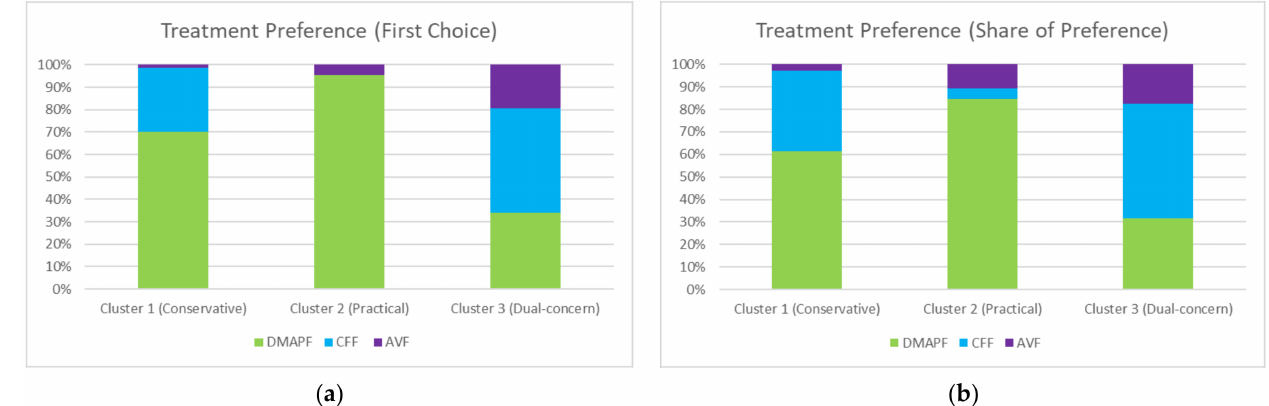
Figure 6. Treatment preferences for the three common flaps: DMAPF (green), dorsal metacarpal artery perforator flap; CFF (blue), cross-finger flap (with groin skin graft); AVF (purple), arterialized venous flap. Most patients in cluster 3 preferred CFF, while clusters 1 and 2 favored DMAPF. ( a ) First-choice method; ( b ) share-of-preference method.